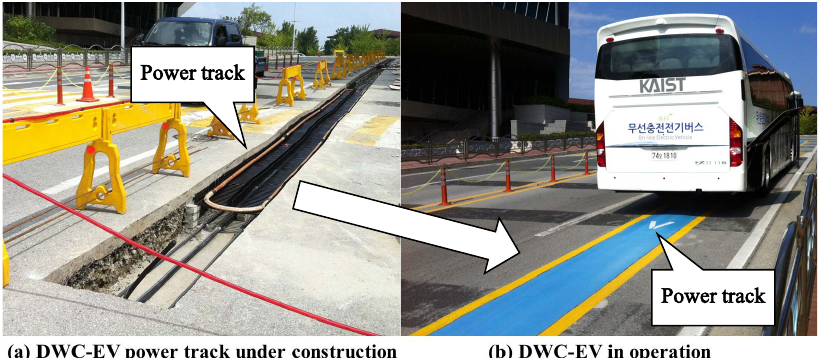
Figure 1. KAIST OLEV: one of the dynamic wireless charging EVs (DWC-EVs), ( a ) under construction; ( b ) in